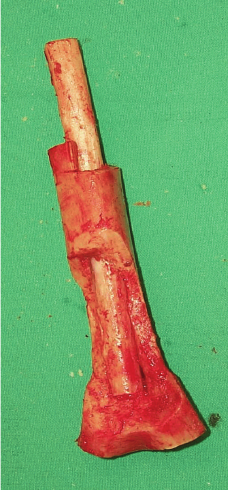
Figure 4: Fibula graft inside the irradiated bone